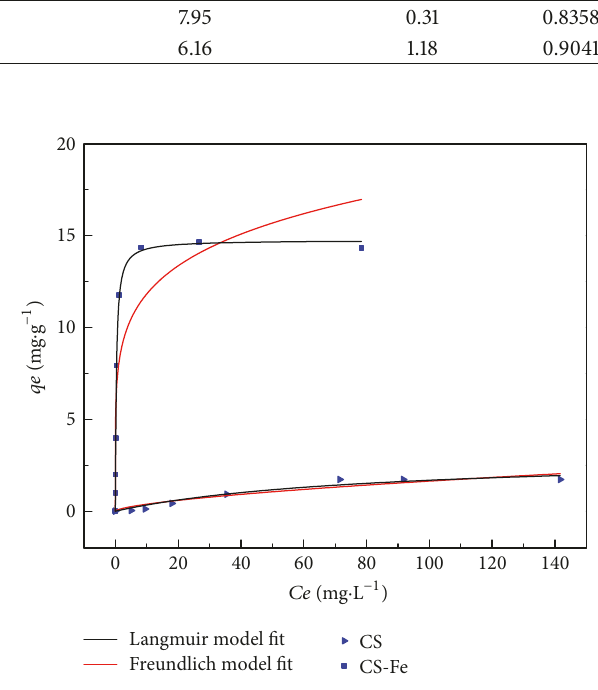
Figure 2: Effect of solution pH on the adsorption of As(V) for CS and CS-Fe (adsorbent dose 5g L −1 ; temperature 30 ∘ C; As(V) concentration 40 mg L −1 ).